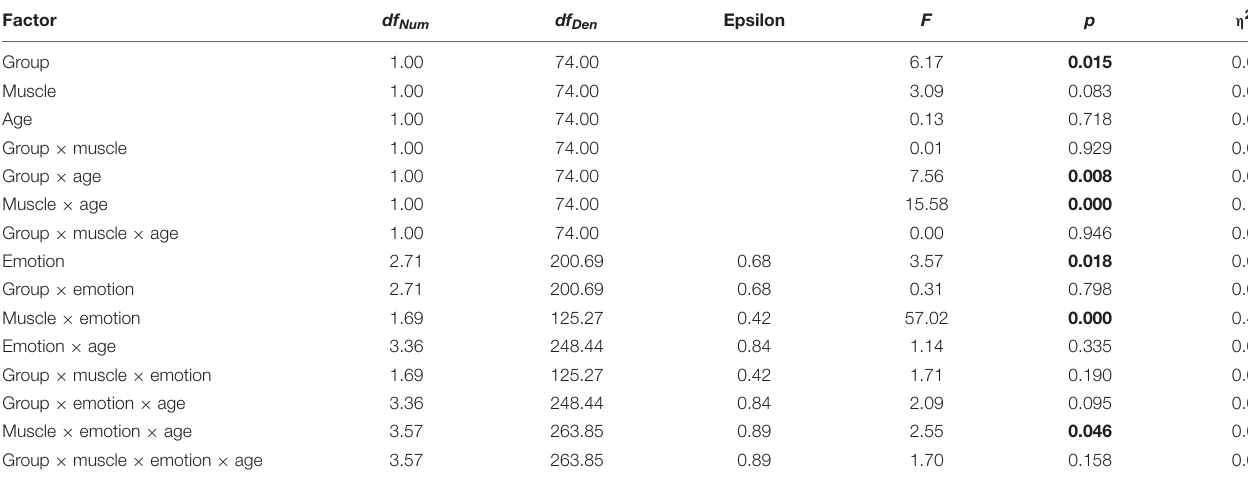
Group × muscle × emotion × age